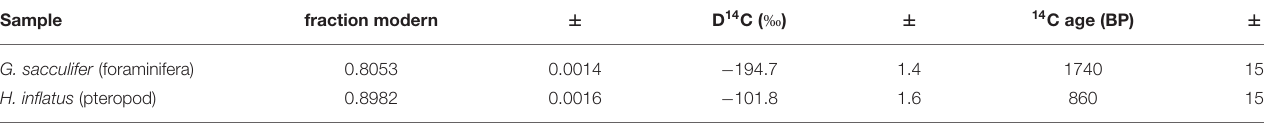
TABLE 4 | 14 C ages of Globigerinoides sacculifer (planktic foraminifera), and Heliconoides inflatus (pteropod) from the CAR2000-MC-2 core in the Cariaco Basin. Sample